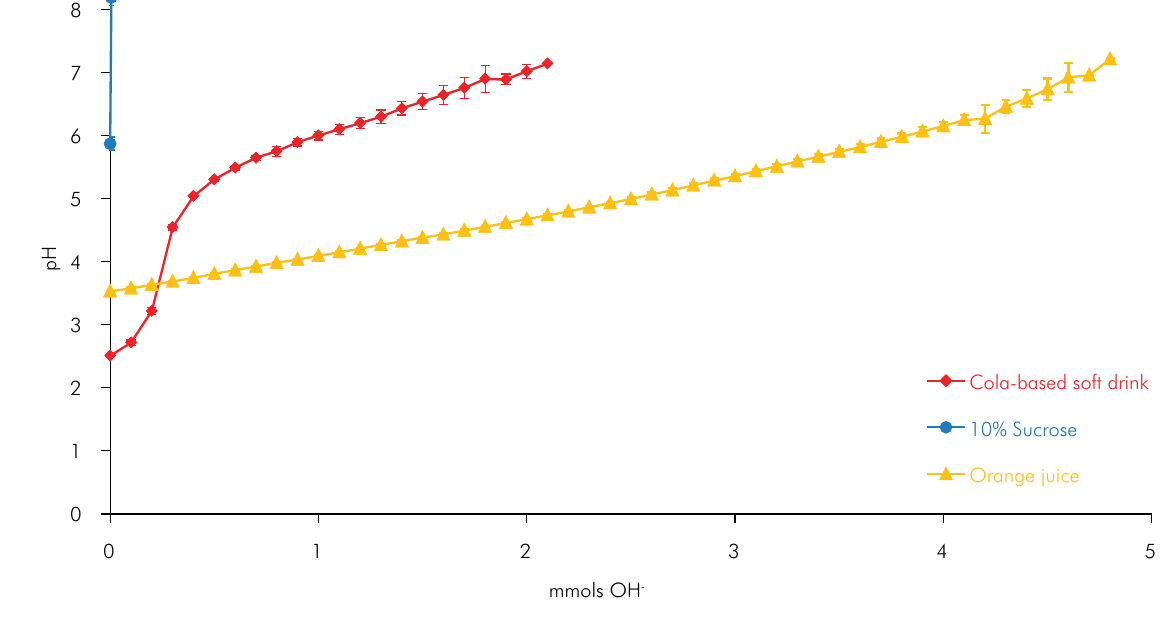
Figure 2. pH changing according to amount of mmols of NaOH added to 50 ml of beverage (mean, n = 5).